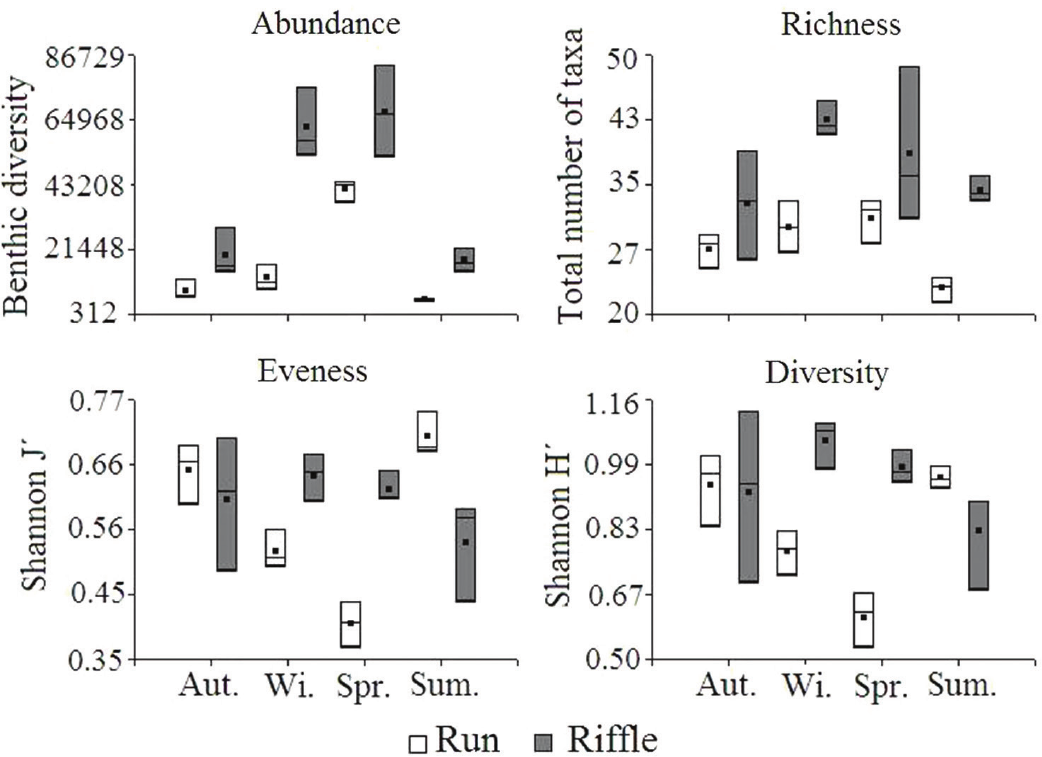
Figure 6. Box plots for macroinvertebrate benthic abundance, taxonomic richness, diversity and evenness in run and riffle of the study site. Seasons: autumn (Aut.), winter (Wi.), spring (Spr.) and summer